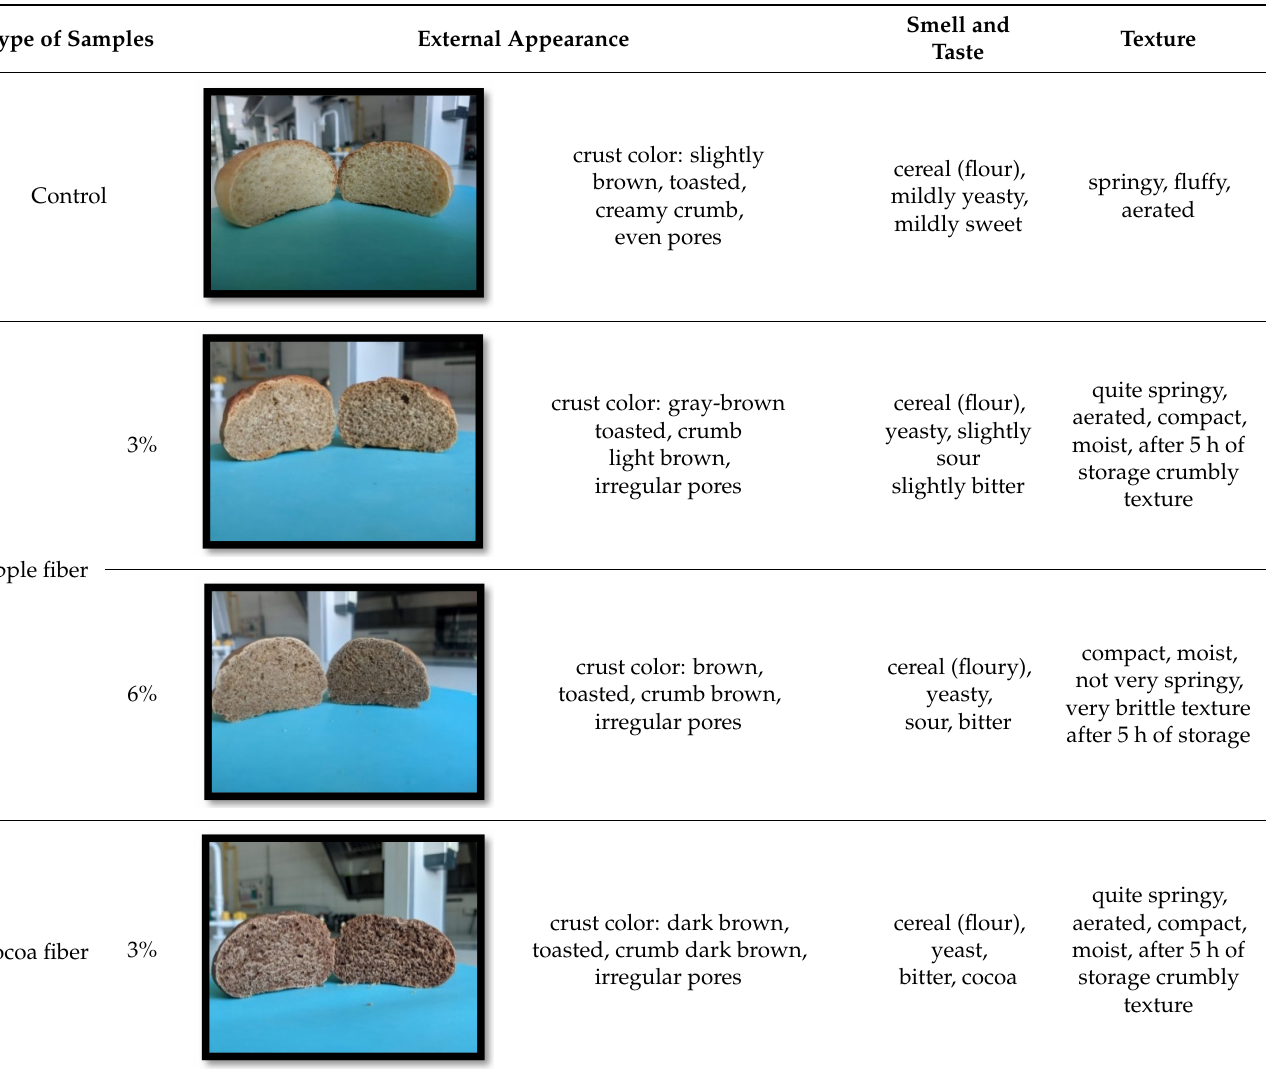
Table 6. Sensory features of the designed